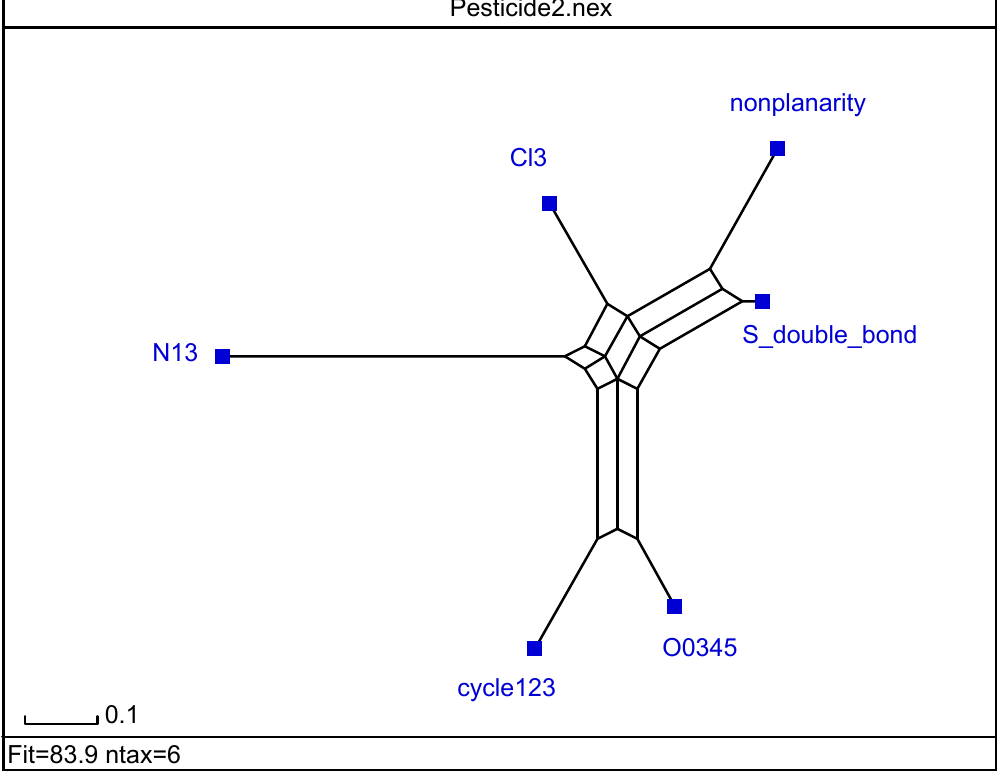
Figure 10. PCA F